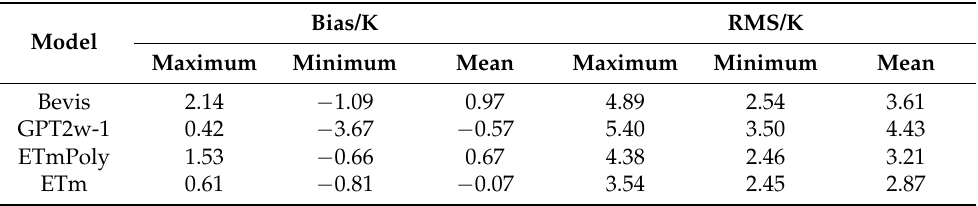
Table 3. RMS and bias values of four Tm Models in 2021 using 12 non-modeling stations.